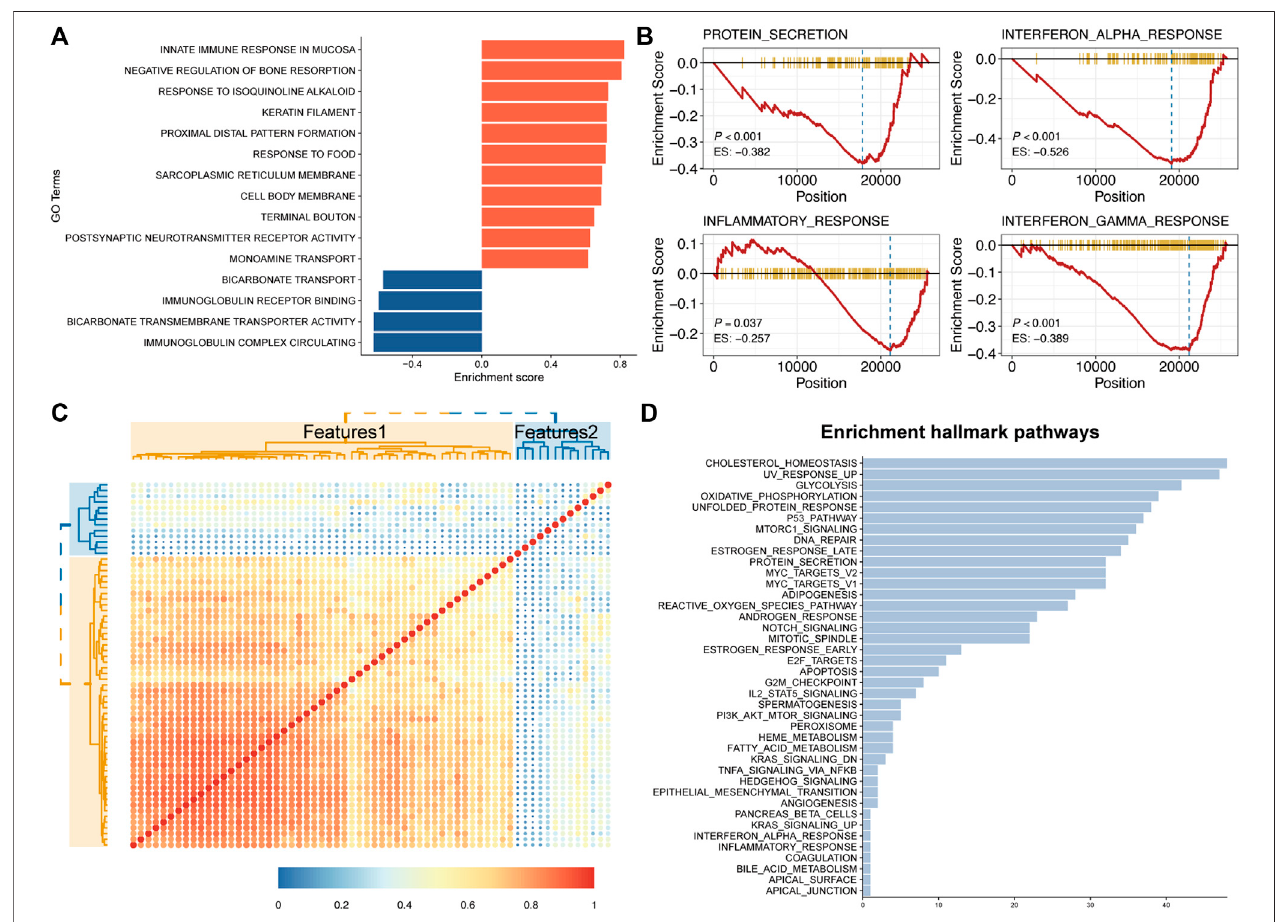
FIGURE 5 | Global gene set pathway analysis. (A) Gene Ontology pathway enrichment analysis between CT signatures and RNA-Seq expression. (B) GSEA showed several Immune related pathways were downregulated in high CT signature patients. (C,D) Correlation between 64 deep CT features and their enrichment hallmark